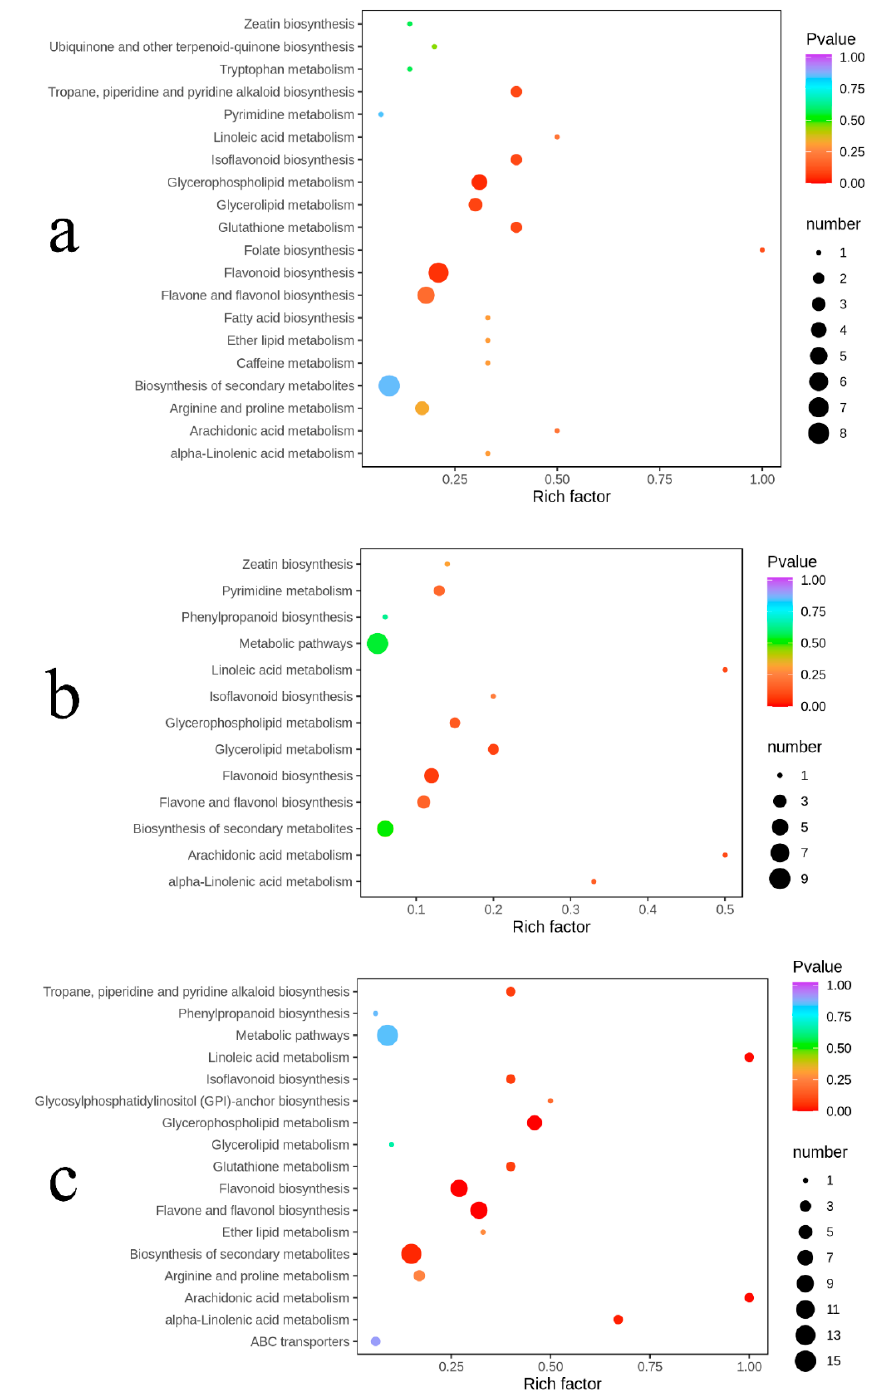
Figure 6. KEGG enrichment maps of di ff erential metabolites: ( a ) PB vs. PC; ( b ) PB vs. CC; ( c ) PC vs. CC. The abscissa represents the enrichment factor of the pathway and the ordinate shows the names of pathways. The color of the dot represents the p -value, and the deeper the red of the dot, the stronger the enrichment e ff ects. The size of points represents the number of metabolites enriched in the